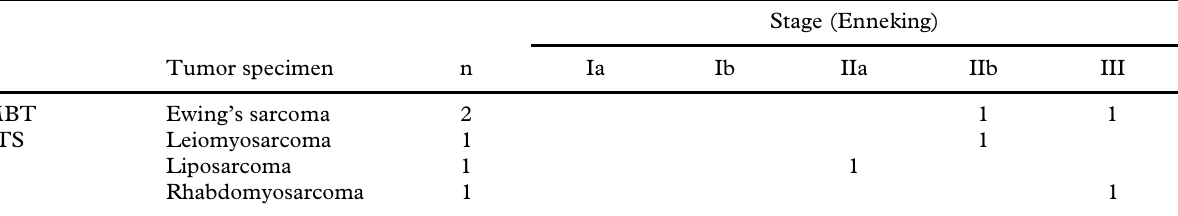
Table 2. Tumor samples with measurable telomerase activity